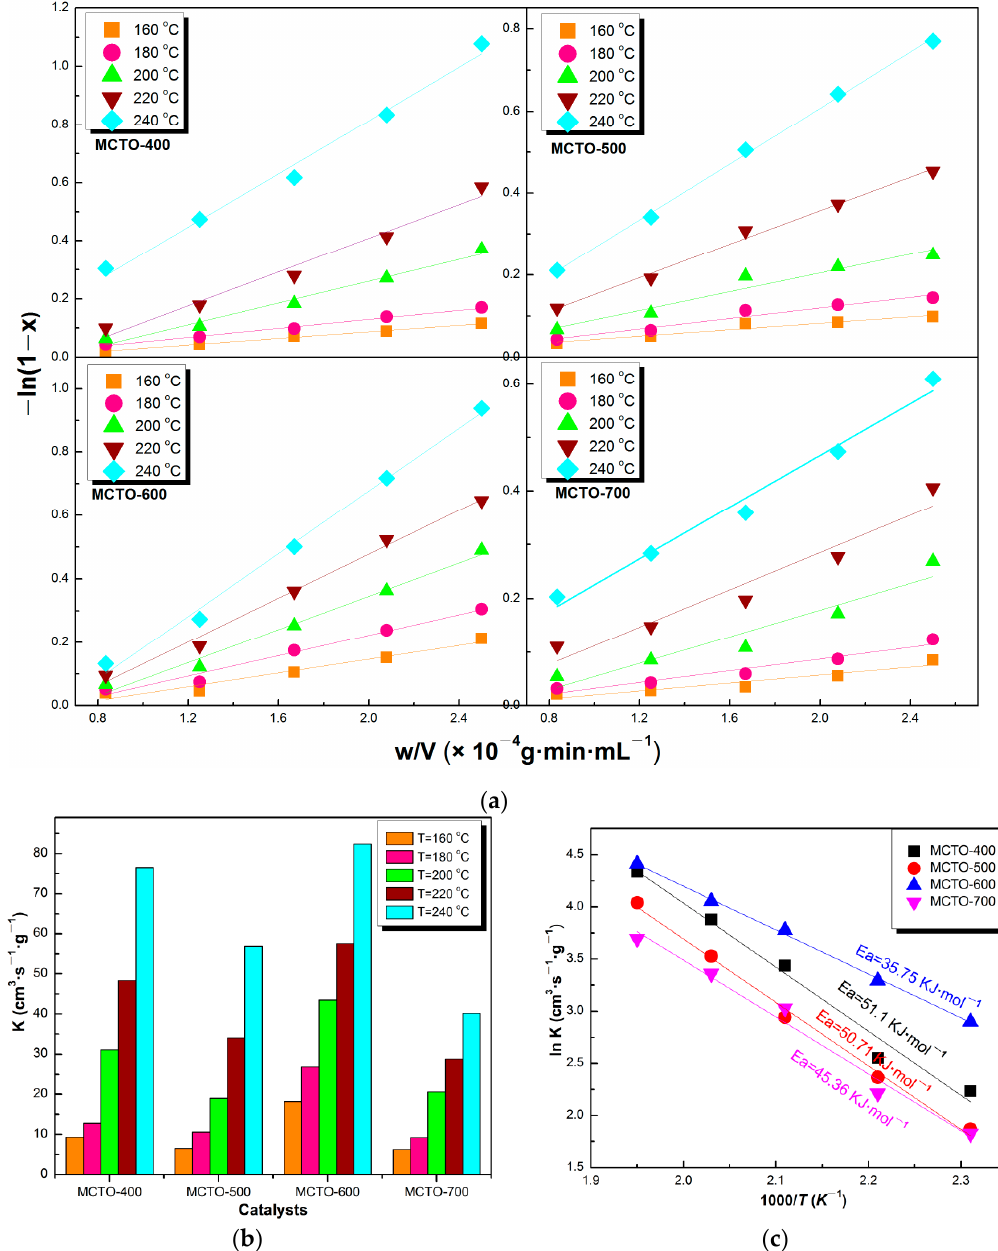
Figure 10. − ln(1 − x) versus w/V plots ( a ), reaction rate constant ( b ), and Arrhenius plots ( c ) of MCTO-400, MCTO-500, MCTO-600, and MCTO-700.